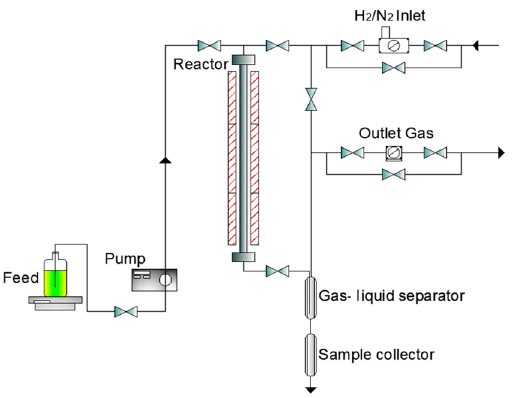
Figure 2. Schematic diagram of the used bench-scale unit for hydrotreating experiments (experimental facility of ORLEN UniCRE a.s.).